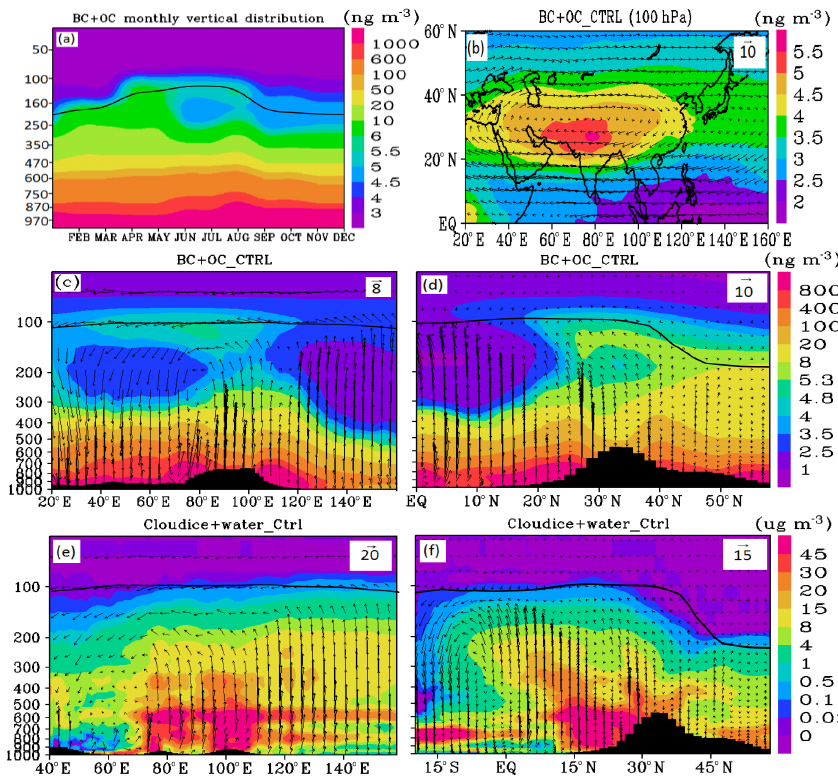
Figure 3. Distribution of BC and OC aerosols (ngm − 3 ) together from CTRL simulations: (a) monthly variations averaged for the region 70– 120 ◦ E, 25–45 ◦ E. Seasonal mean distribution of BC and OC aerosols (ngm − 3 ) together from CTRL simulations: (b) at 100 hPa; (c) averaged for 15–35 ◦ N; and (d) averaged for 80–110 ◦ E. Seasonal mean distribution of cloud ice + cloud water (µgm − 3 ) from CTRL simulations: (e) averaged for 10–25 ◦ N and (f) averaged for 80–110 ◦ E. Black arrows indicate wind vectors. The vertical velocity field has been scaled by 1000. A black line represents the tropopause. In panels (a, c, d, e, f) the tropopause is averaged over the same region where the field parameter is